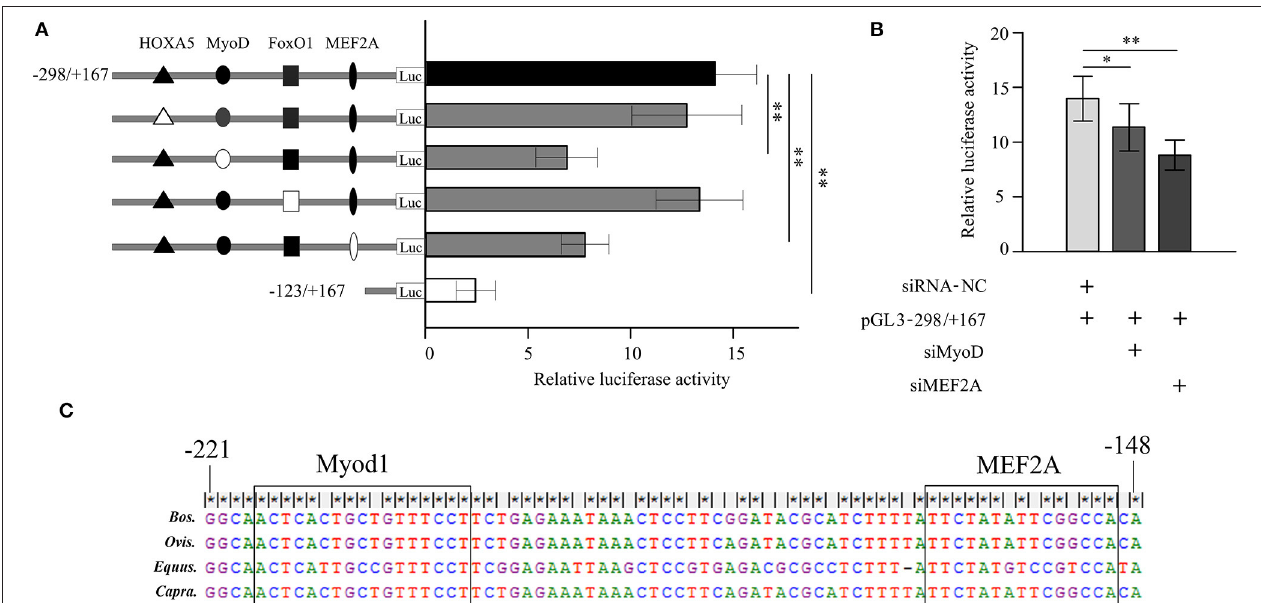
FIGURE 5 | Analysis of transcriptional activity for the corresponding transcription factor in Qinchuan cattle myoblast cells (QCMCs). (A) Site-directed mutagenesis for homeobox A5 (HOXA5), myogenic differentiation 1 (Myod1), forkhead box O1 (FoxO1), and myocyte enhancer factor 2A (MEF2A) sites were carried out in the construct pGL − 298/ + 167. The correspondence constructs were transiently transfected into QCMCs and pGL − 123/ + 167 construct was used as a negative control. (B) Myod1 and MEF2A knockdown by small interfering RNA (siRNA) co-transfected with pGL − 298/ + 167 in QCMCs. The NC siRNA was used as a negative control. The results are expressed as the means ± SD in arbitrary units based on the firefly/ Renilla luciferase activity for triplicate transfections. (C) Multialignment sequence analysis of the Myod1 and MEF2A transcription factor binding sites in the promoter region of the LATS 1 gene in cattle, sheep, horse, and goats. “*” p < 0.05 and “**” p < 0.01.